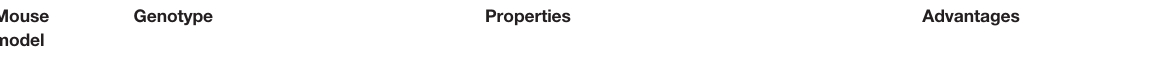
TABLE 2 | HLA Transgenic immunode fi cient mouse